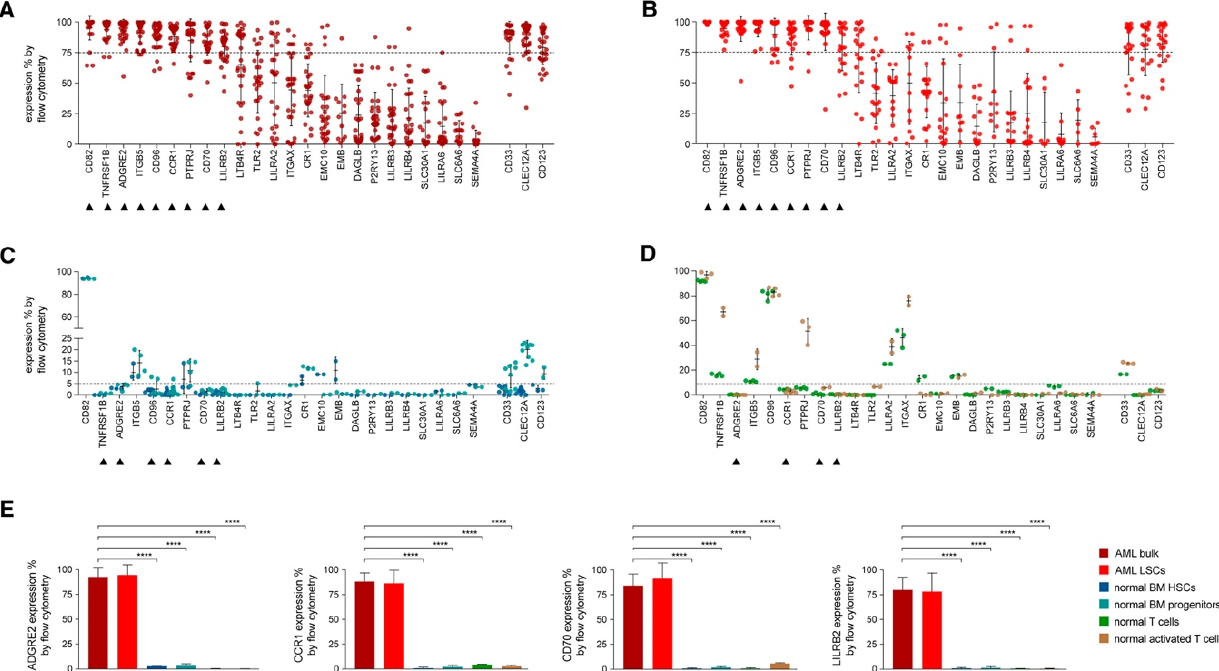
Figure 3. Flow Cytometric Analyses in Primary AML Samples and Normal Haematopoietic Cells. ( A – D ) Expression (% positive) of the 24 candidate antigens and the three CAR targets in current clinical investigation (most right three) in bulk AML population ( A ), in leukaemic CD34 + CD38 − cells ( B ), in normal BM CD34 + CD38 − CD45RA − CD90 + HSCs (blue), CD34 + CD38 + progenitor cells (light blue) ( C ), or in freshly purified (green) or activated (brown) normal CD3 + peripheral blood T cells ( D ). Data are represented as mean ± SD. ( E ) Summary of expression levels (mean ± SEM) of four top targets in indicated cell populations. **** p < 0.0001 (Student’s t -test). Reprinted from Perna F, Berman SH, Soni RK, et al. Integrating